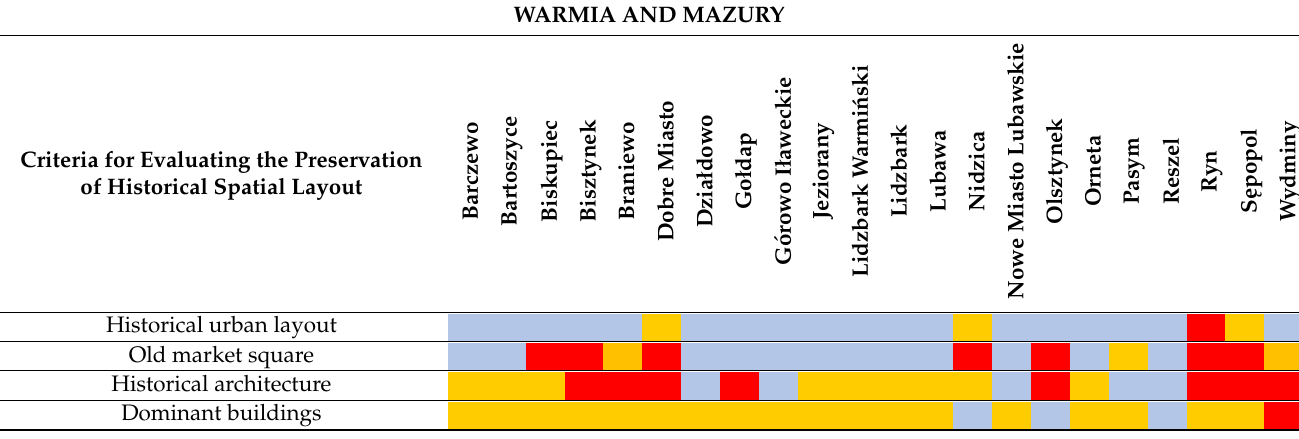
Table 15. Preservation of historical spatial components in Polish towns in the Region of Warmia and Mazury. WARMIA AND